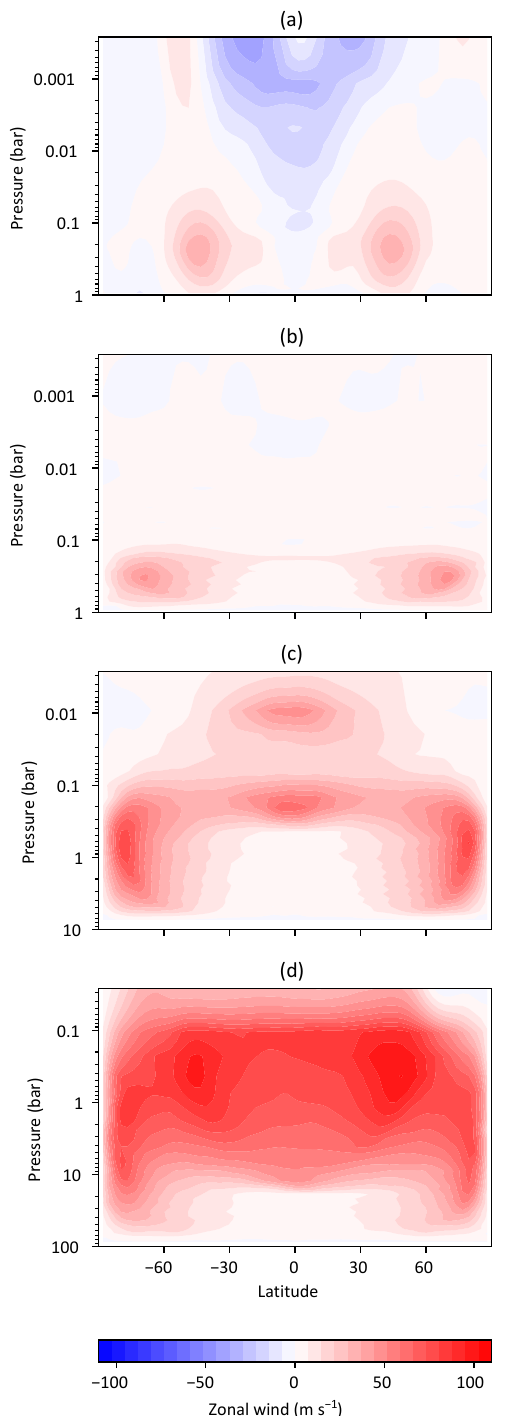
Figure 9. The time-averaged and longitudinally averaged zonal wind, in metres per second, versus latitude and pressure level, for (a) (cid:127) = (cid:127) E = 7 . 3 × 10 − 5 rads − 1 and p s = 1bar, (b) (cid:127) = (cid:127) E / 20 and p s = 1bar, (c) (cid:127) = (cid:127) E / 20 and p s = 7.9bar, and (d) (cid:127) = (cid:127) E / 20 and p s = 92bar. These results are obtained with 30 un- equally spaced sigma levels and T42 horizontal